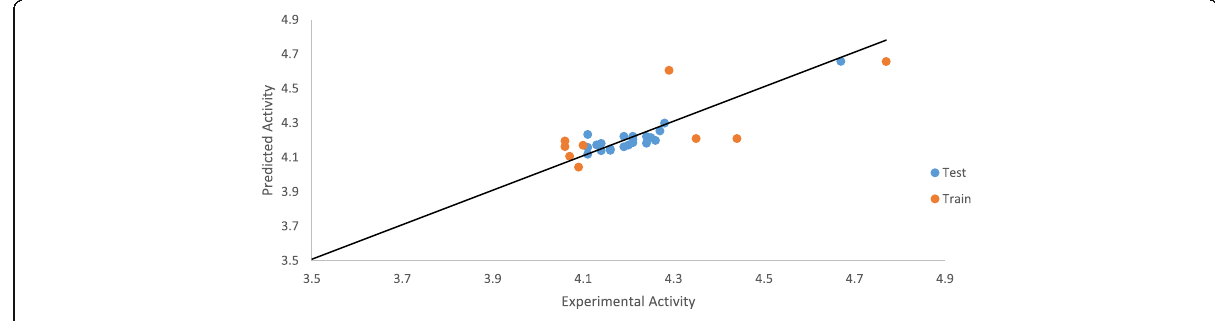
Fig. 2 Graph of predicted activities versus experimental activities